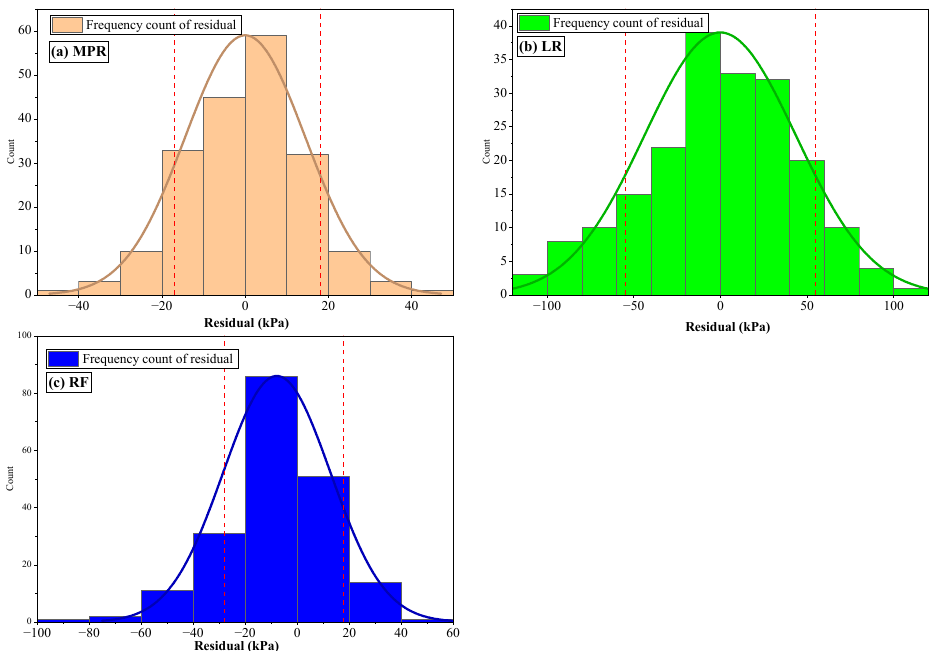
Figure 4. Normal distribution of the residual errors of the 5-fold cross-validation training dataset: ( a ) MPR model, ( b ) LR model, and ( c ) RF model.